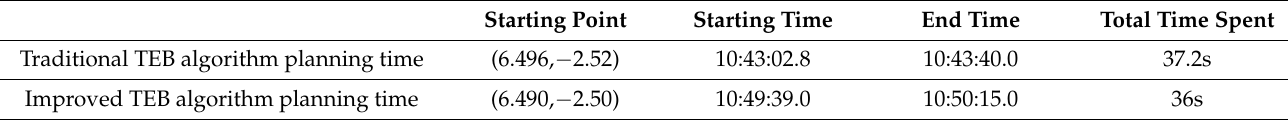
Table 2. Time comparison after improving TEB